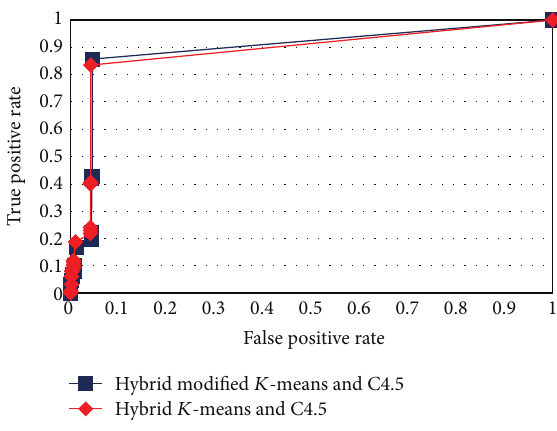
Figure 7: ROC curve for testDS4. Table 2: The accuracy results of the MAS-IDS versus hybrid 𝐾 - means and C4.5